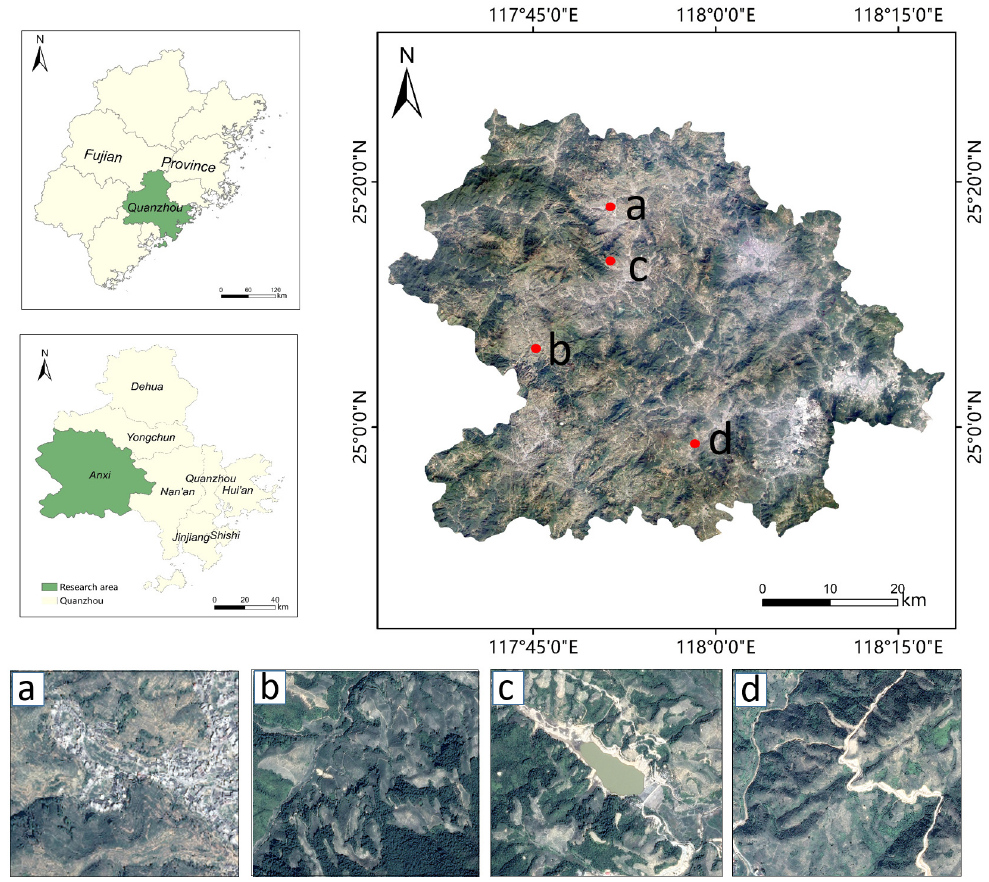
Figure 1. Overview of the study area in Anxi, Fujian Province, China; ( a – d ) are enlarged views of four typical tea plantation areas.